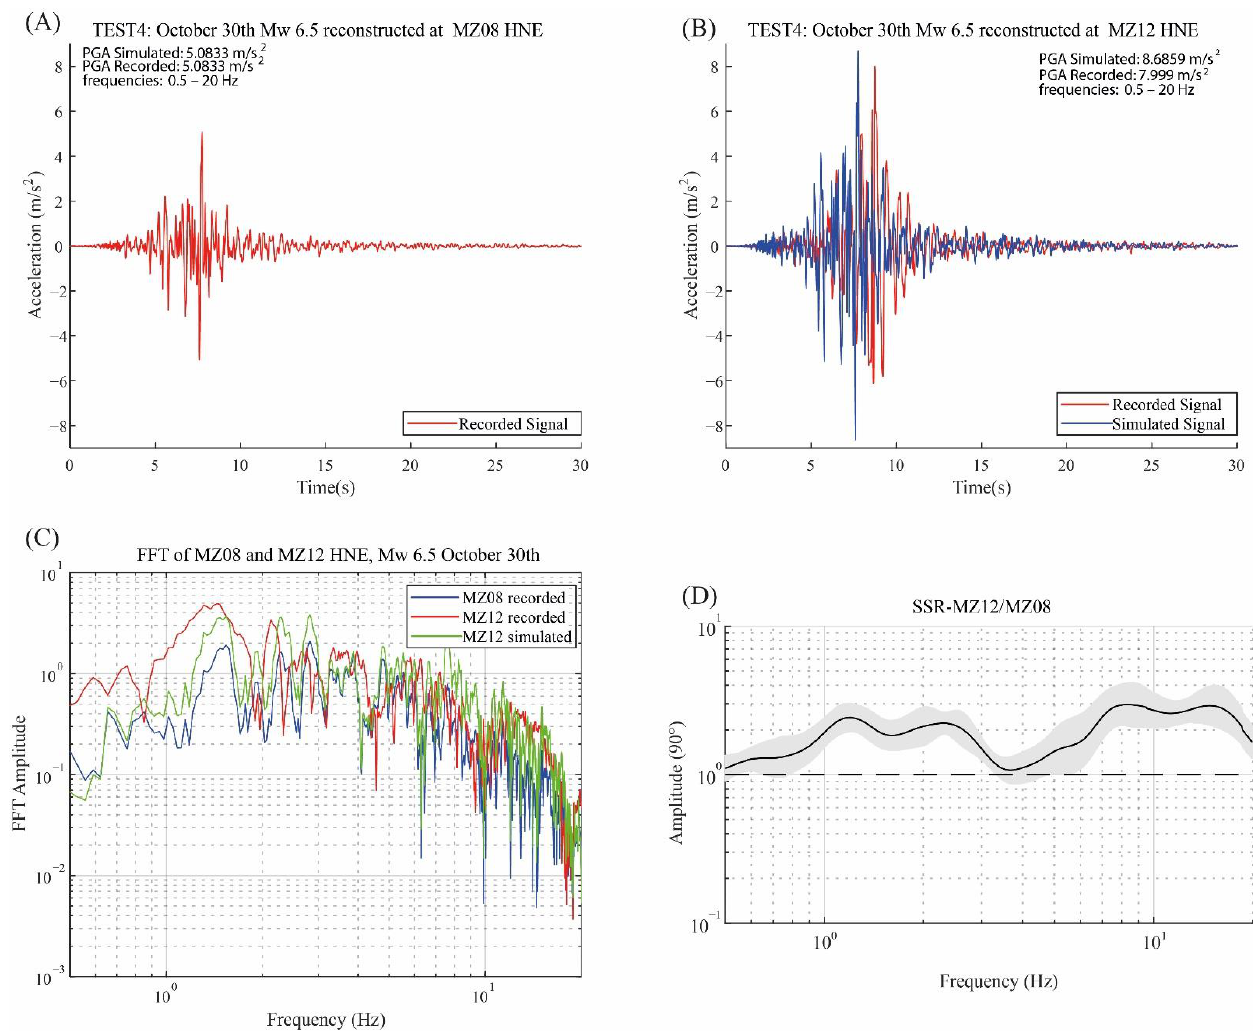
Figure 9. Comparison between recorded and simulated signals (EW component) at MZ12 for Test 4, in the frequency band of 0.5 – 20 Hz: ( A ) recorded signal at MZ08; ( B ) recorded and simulated signals at MZ12; ( C ) comparison of the FFT amplitudes between the signals recorded by MZ08 and MZ12, and the signal simulated at MZ12; ( D ) SSR ±1 standard deviation (gray) on the EW direction (MZ12 on MZ08).